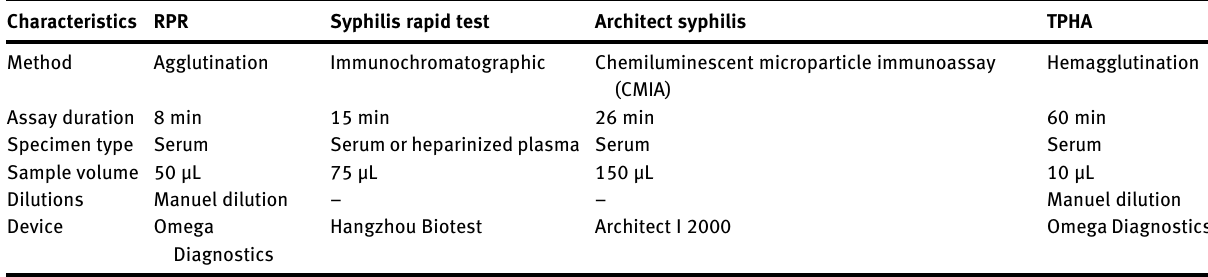
Table  : Characteristics of four serological methods in this study. Characteristics